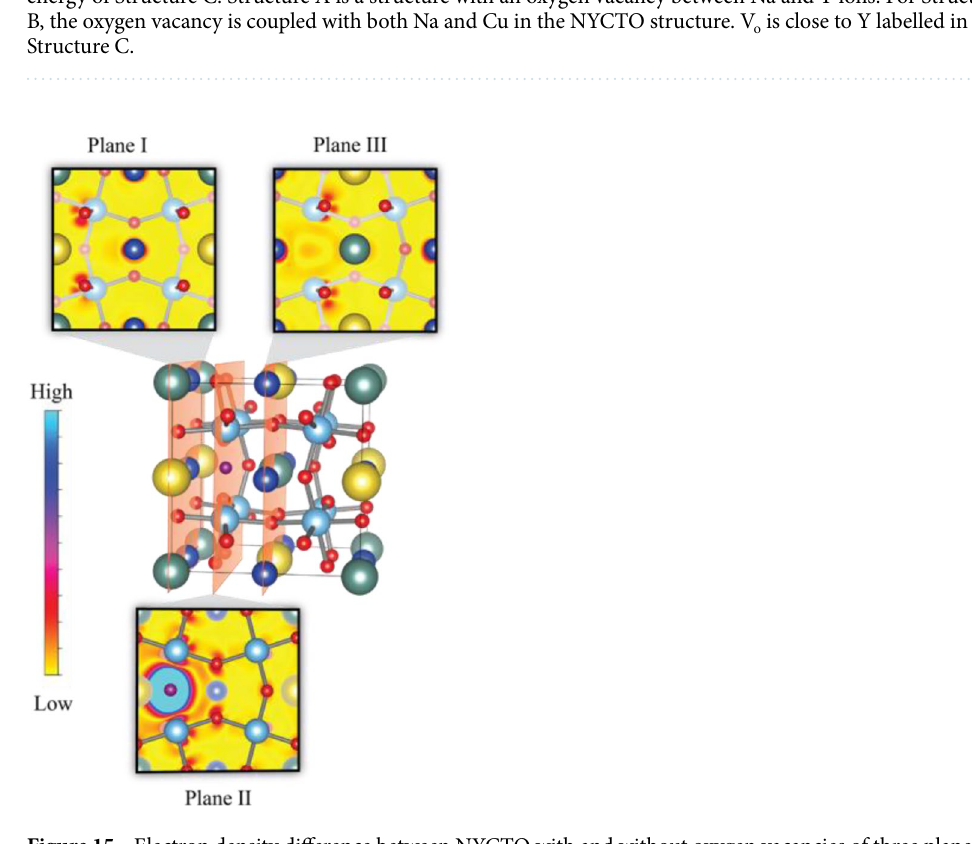
Figure 15. Electron density difference between NYCTO with and without oxygen vacancies of three planes, namely, planes